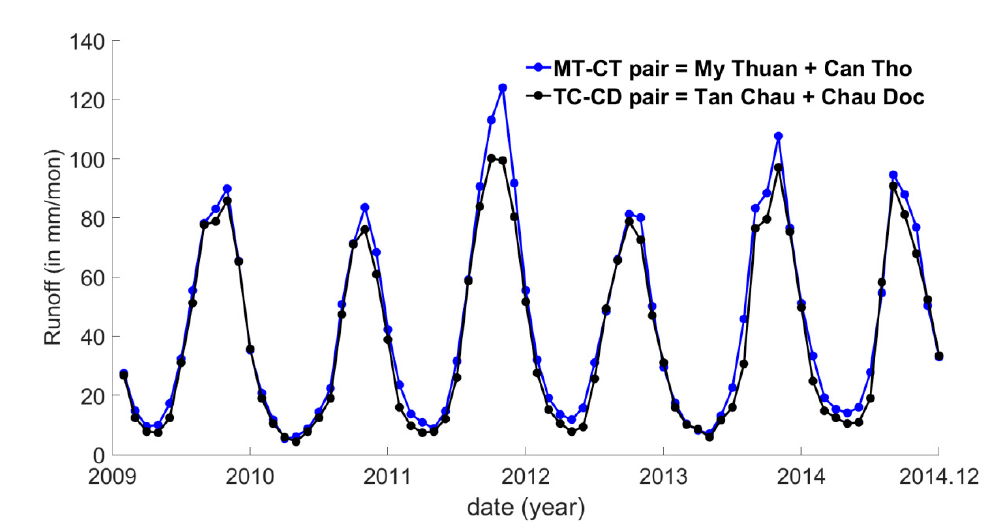
Figure 2. Time series of runoff for My Thuan–Can Tho (MT–CT) and Tan Chau–Chau Doc (TC–CD) station pairs.